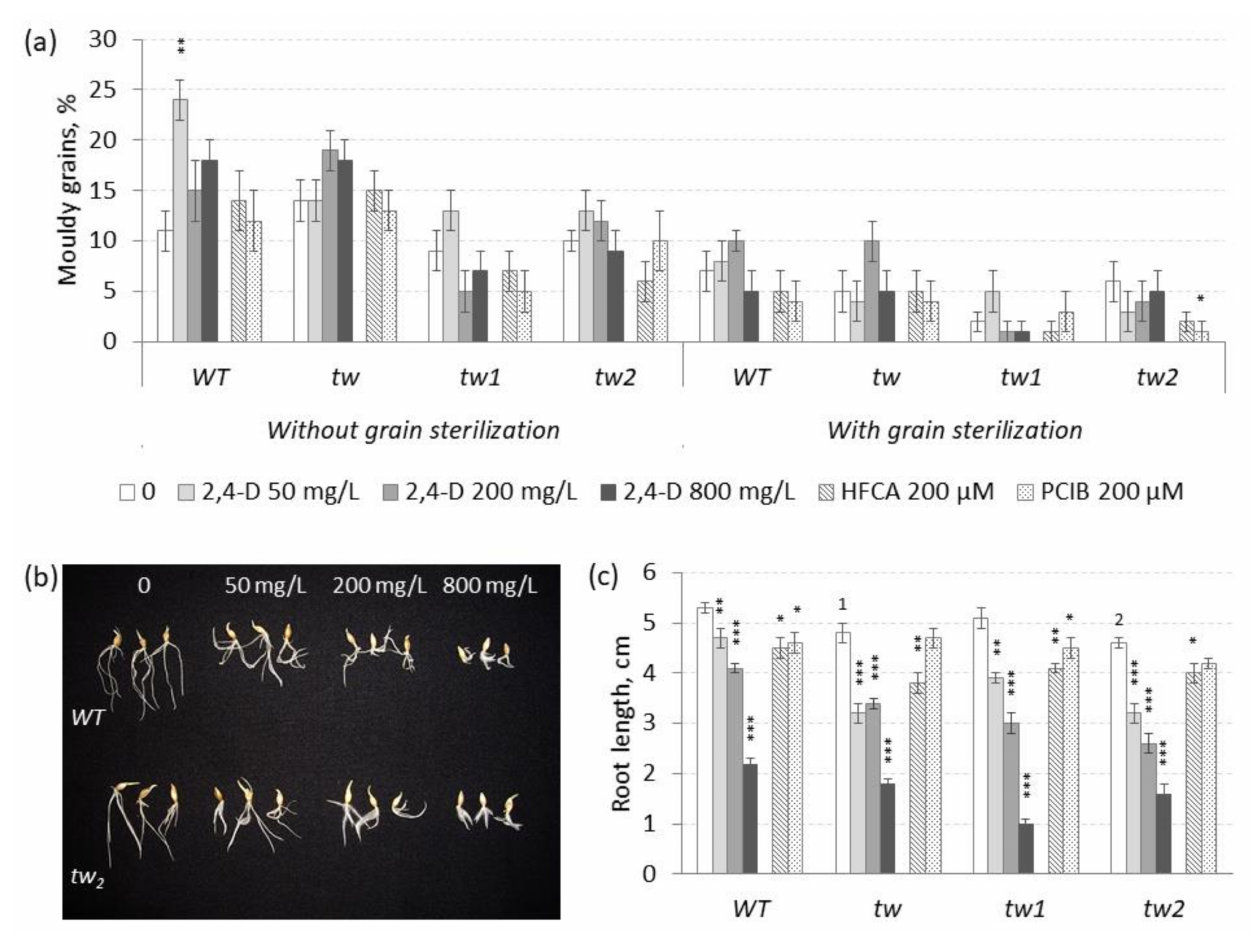
Figure 2. Effects of 2,4-D over a range of 50–800 mg L − 1 and the auxin inhibitors HFCA and PCIB on ( a ) the frequency of mouldy grains (%) and ( b , c ) the root length (cm) of unsterilized germinating grains of tw mutants and the WT , as measured after 5 days. For mouldy grains, n = 10 Petri dishes (100 grains); for root length, n = 30. Grain was produced in 2013, and the MGG assay was performed in 2017. The asterisks represent significant differences (* p < 0.05; ** p < 0.01; *** p < 0.001) between the control and the 2,4-D treatment. The numbers denote significant differences ( 1 p < 0.05; 2 p < 0.01) between the controls of the tw -type mutant and the WT